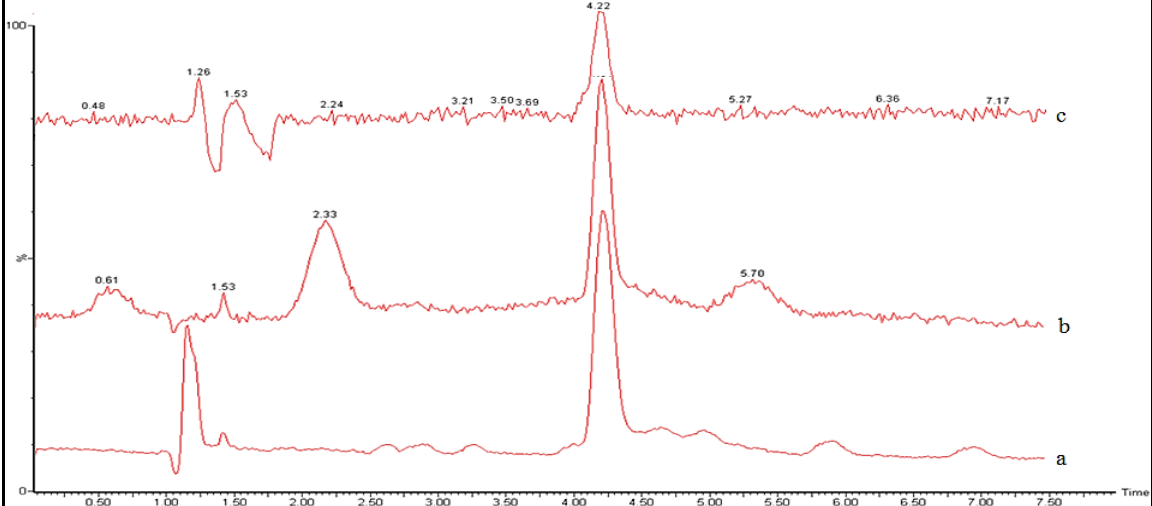
Figure 4. The chromatogram of caffeine standard (a), EtOH extract (b), and microcapsule (c). Positive ion mode of Time-of-flight mass spectrometry electrospray ionization (TOF MS ESI+). Retention time 4.22 min